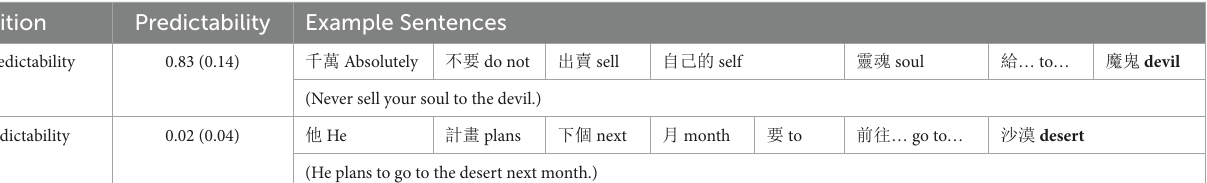
TABLE 1 Example sentences of high-and low-predictability